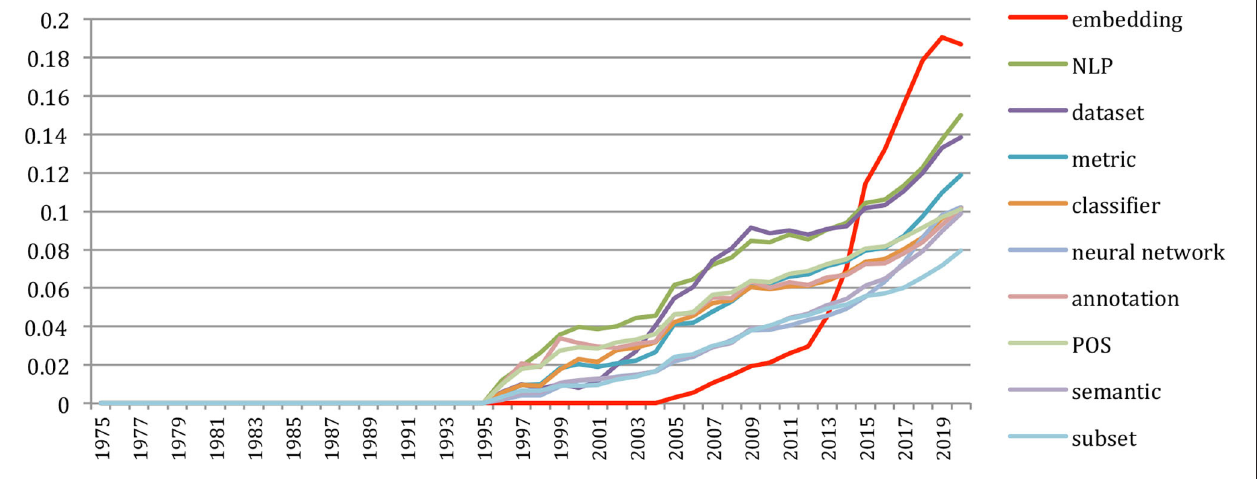
FIGURE 50 | Main contributions of the EMNLP conference series (% of topical